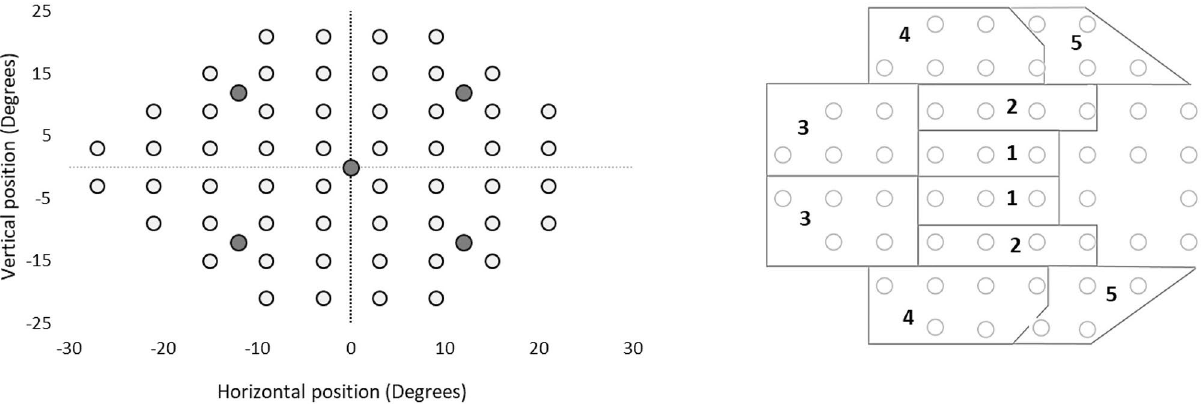
Figure 1. The glaucoma hemi-filed sectors in EMP test grid; Left panel: EMP 54 points test grid (depicted as circles) with the stimulus locations (blank circles) in degrees and illustrating the position of the fixation stimuli in filled circles (grey), Right panel: EMP test grid partitioned into 10 sectors corresponding to retinal nerve fibre layer anatomy [Åsman and Heijl (1992)]. The 10 sectors include 5 demarcated sectors in the superior hemi-field and five mirrored sectors in the inferior hemi-field across the horizontal meridian. The five sector pairs are numbered from 1 to